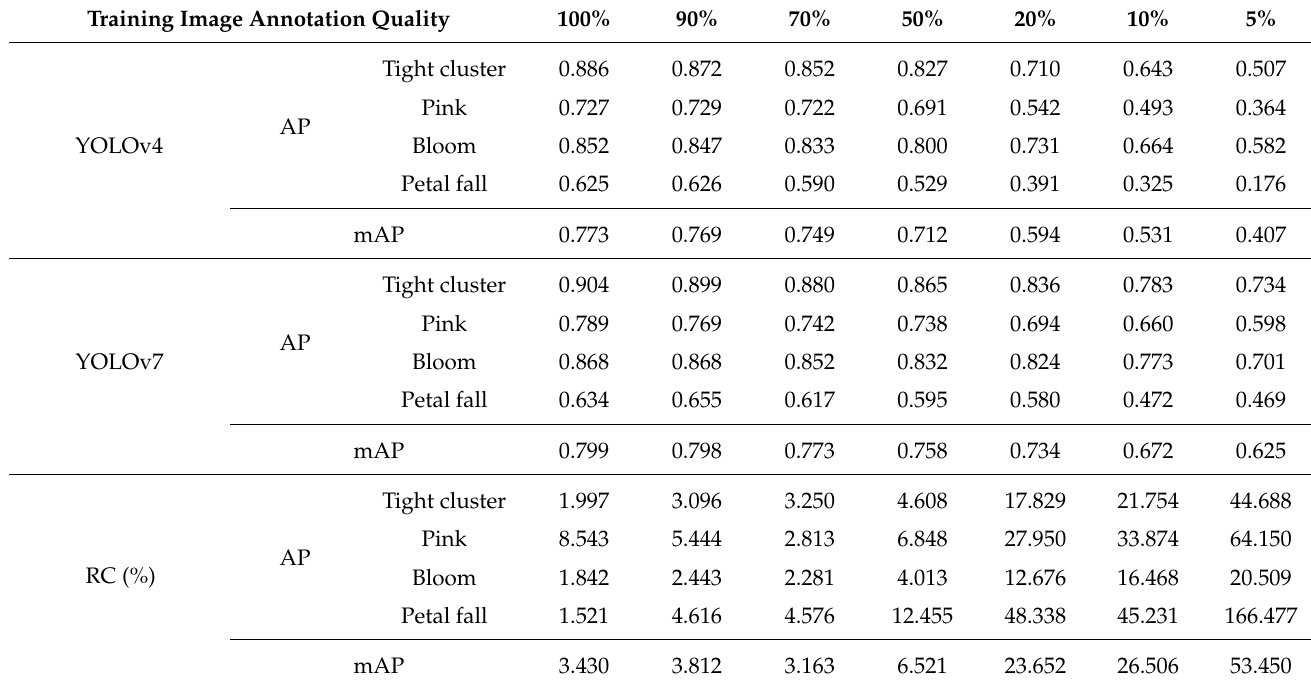
Table 3. YOLOv4 and YOLOv7 model performance comparison based on the test